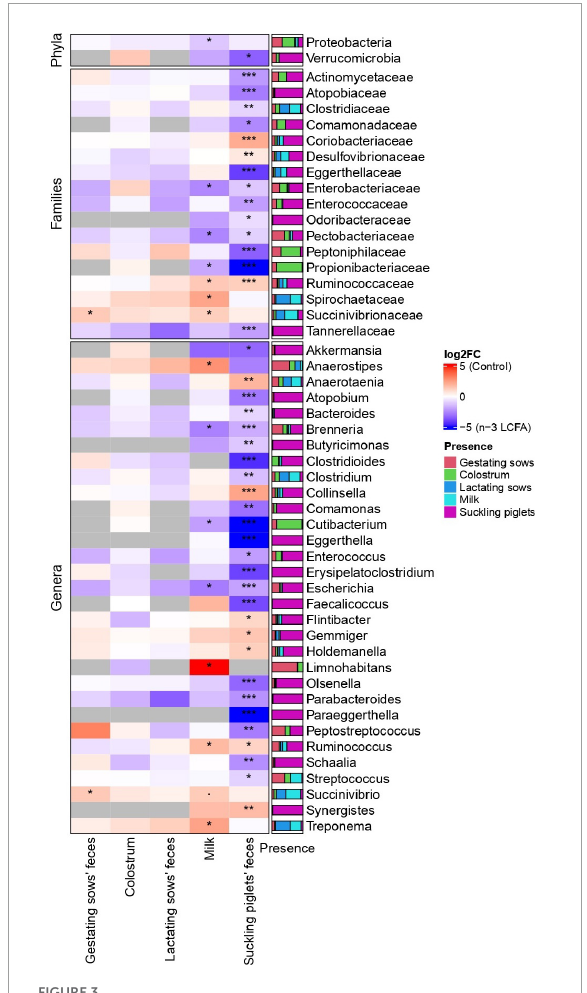
FIGURE3 Heatmap representing the differentially abundant phyla, families, and genera between control and n-3 LCFA dietary treatments in feces of gestating and lactating sows, colostrum, milk, and feces of suckling piglets. For feces of gestating and lactating sows, colostrum, and milk; n = 11 for control and n = 10 for n-3 LCFA. For feces of suckling piglets; n = 44 for control and n = 40 for n-3 LCFA. Significant differences between treatments were set at P < 0.05 (*), P < 0.01 (**), and P < 0.001 (***). LCFA, long-chain fatty acids.